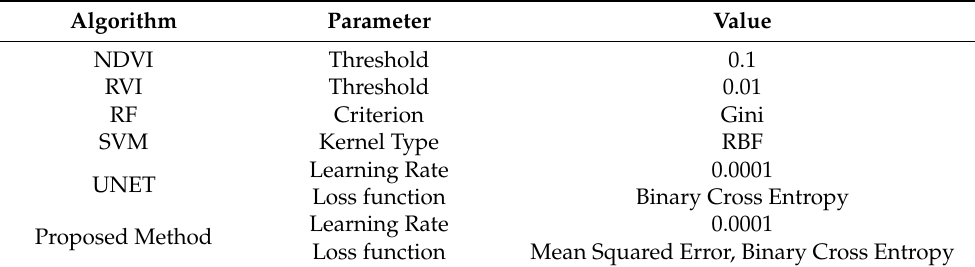
Table 3. The algorithms training processes’ parameters.